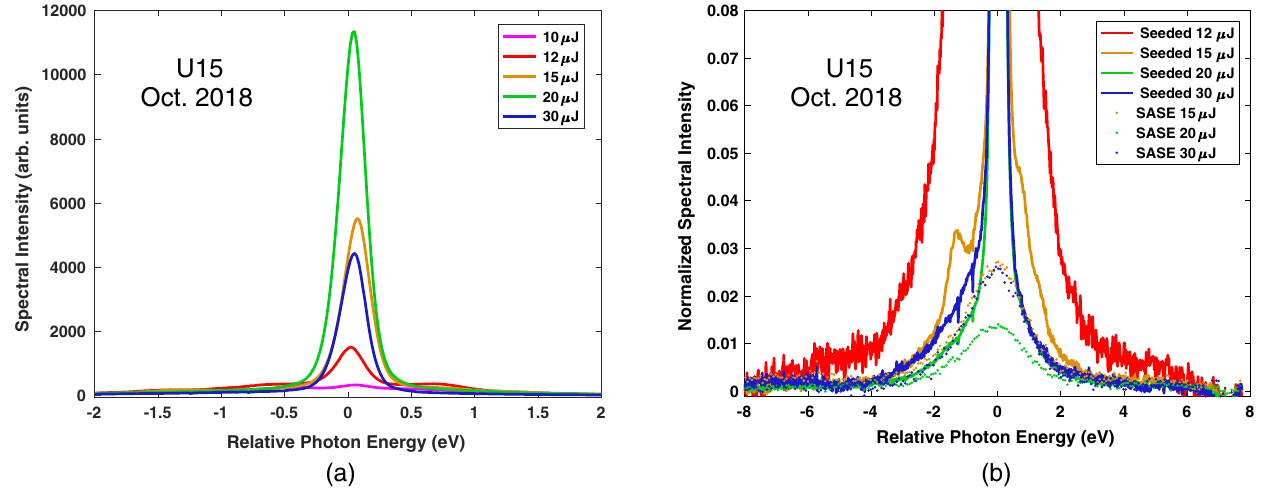
FIG. 9. (a) Oct. 2018 averaged self-seeded spectra at U15 taken at various LH energies. (b) Both self-seeded and SASE ( “ blocked seed ” ) averaged spectra normalized to the peak value of the average amplified seed intensity corresponding to each LH energy value.